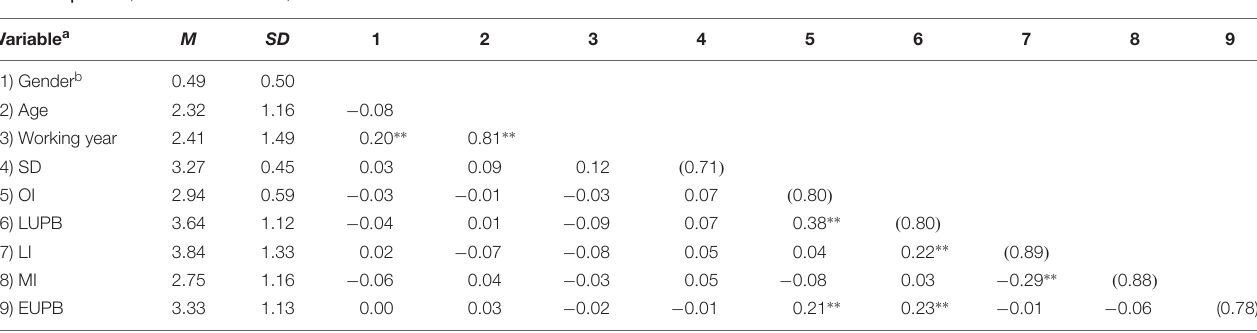
TABLE 2 | Means, standard deviations, and correlations.